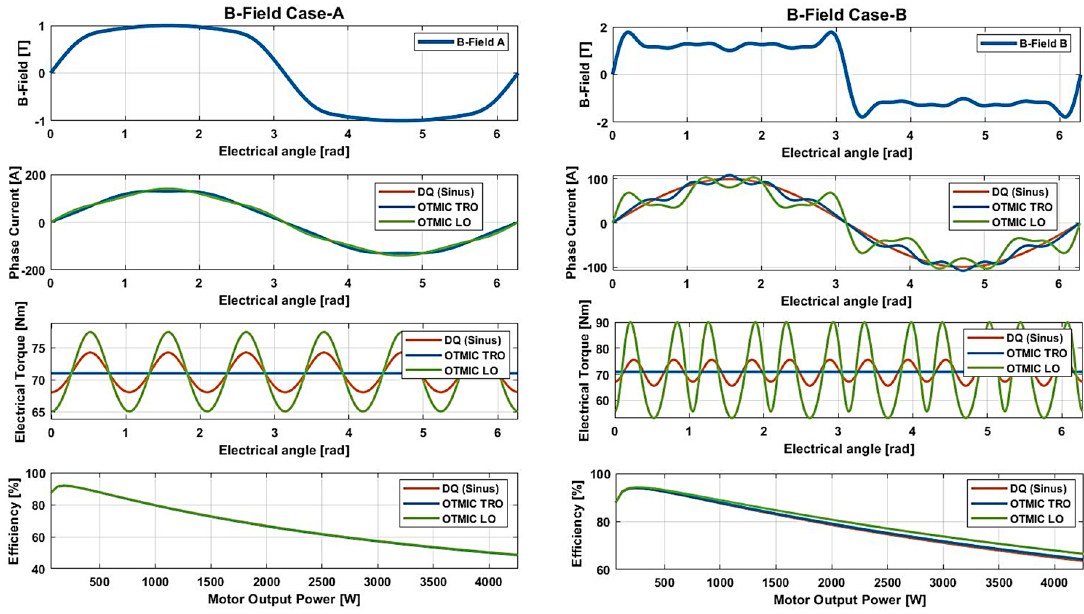
Figure 7. Working principles of the proposed OTMIC control algorithm for two B-Field waveforms.